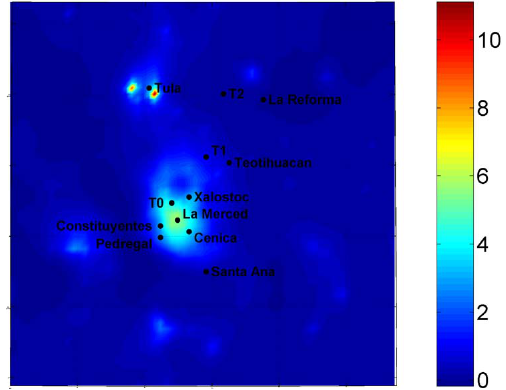
Fig. 10. Predicted increase in ground-level concentrations (µgm − 3 ) of the PM 1 POA after using a lower volatility distribution of OA primary